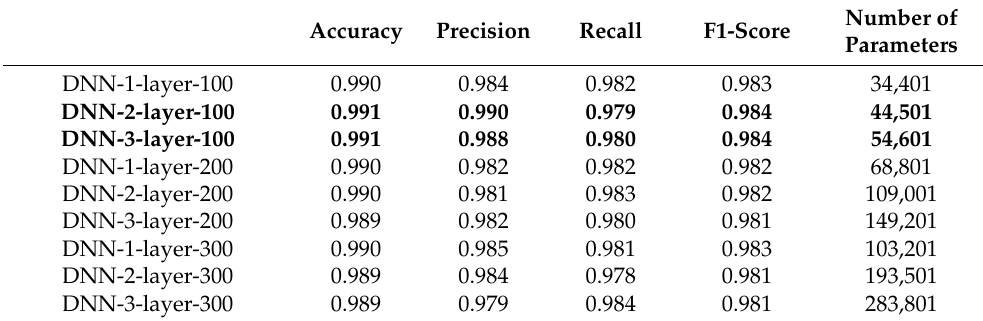
Table 7. Results from the DNN model with various numbers of layers and units per layer. Accuracy Precision Recall